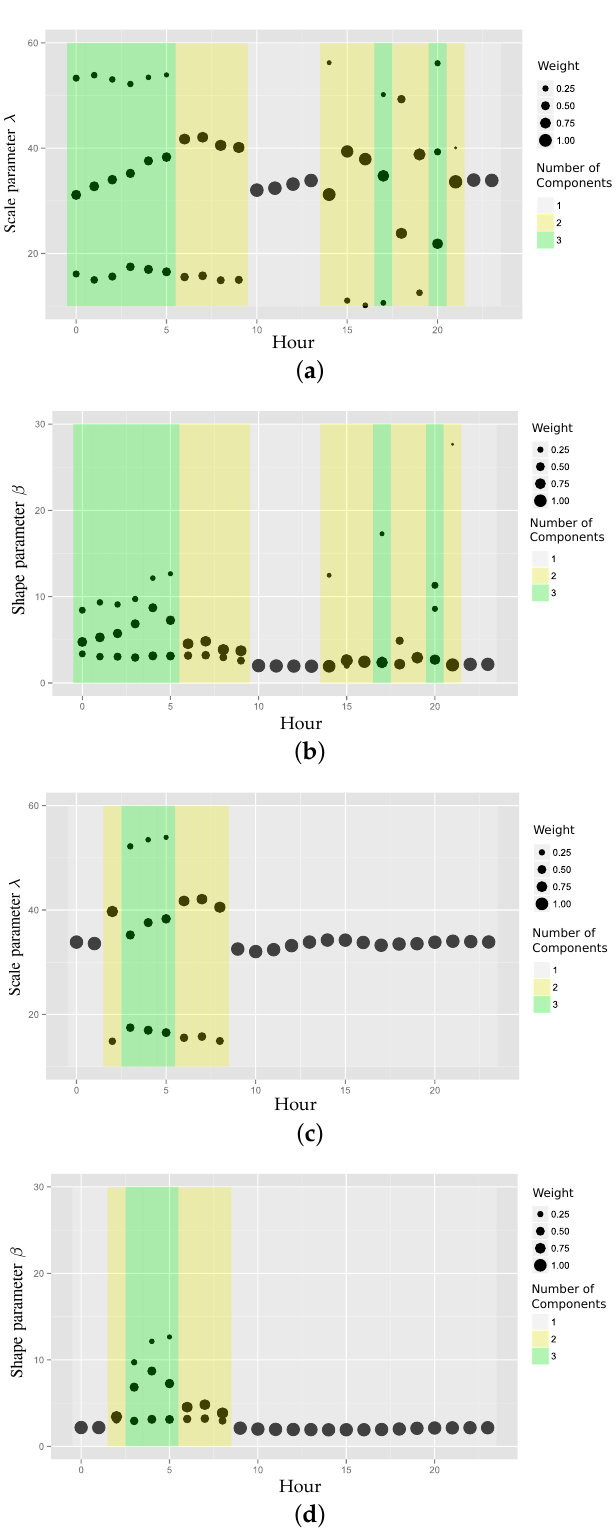
Figure 5. Number of components (according to rough-enhanced-bayesian finite mixture modeling (REBMIX) algorithm), estimated weights, scale and shape parameters for Q4 of year 2010 using wind power generation data. The size of the plotted points is proportional to the estimated weights of the corresponding fitted mixture of Weibull distribution. ( a ) Scale parameter λ . AIC approach; ( b ) shape parameter β . AIC approach; ( c ) scale parameter λ . BIC approach; and ( d ) shape parameter β . BIC